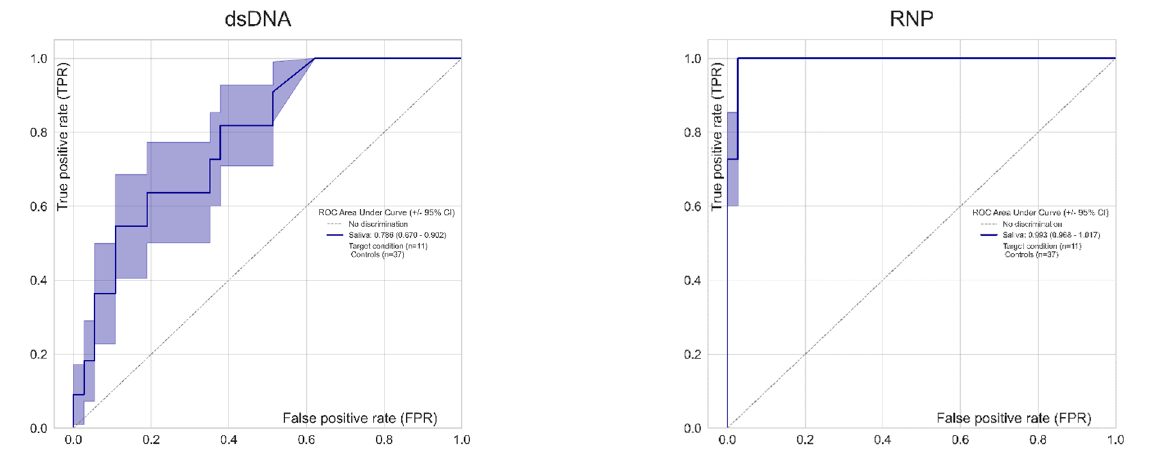
Figure 3. Receiver operating characteristic (ROC) analysis. The results obtained with saliva were used to generate a ROC curve using the serum results as a binary classifier. Results for all autoantibodies were analyzed pooled (all antibodies) or individually for RNP, Ro52, Ro60, and dsDNA. The results show a very high level of discrimination between serum positive and negative samples depending on the antibody titer defined using saliva samples. The area under the ROC curve was 0.97.